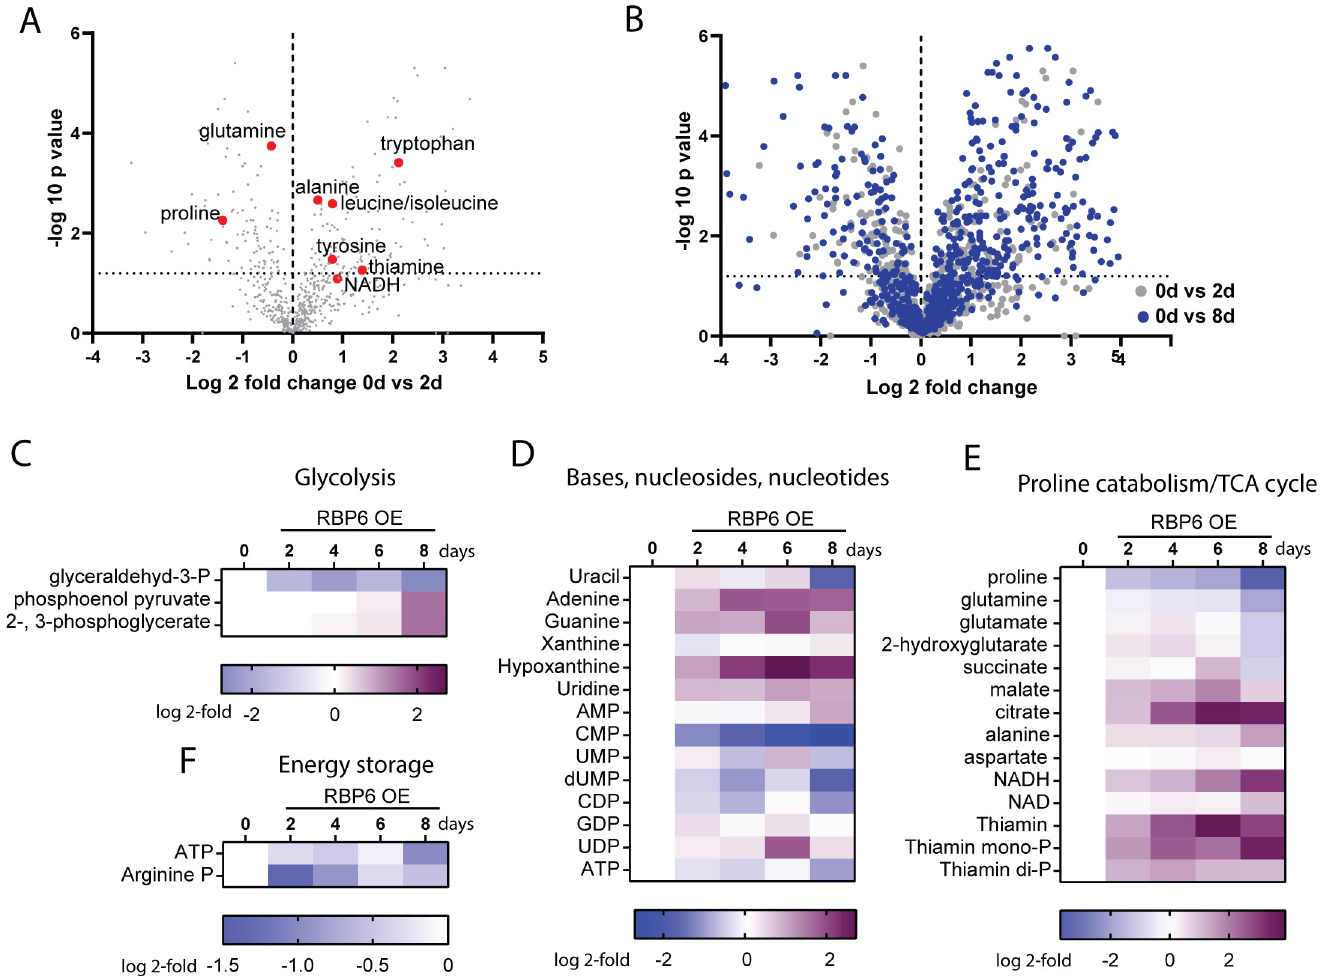
Fig 9. Metabolomics profiling of RBP6 OE cells. (A) Volcano plot showing the full metabolome (698 metabolites) analyzed at day 0 and day 2 upon RBP6 induction. Log2 fold change values of the average of mean peak area from quadruplicate experiments are plotted against the respective − log10 transformed P values. Few key metabolites are highlighted. (B) Volcano plot showing the full metabolome analyzed at day 2 (gray) and 8 (blue) upon RBP6 induction compared to day 0. Log2 fold change values of the average of mean peak area from quadruplicate experiments are plotted against the respective − log10 transformed P values. (D, E, F) Heatmaps showing log2 fold change of average of mean peak area of selected metabolites identified in induced samples compared to uninduced (day 0). The color key differs for each map and is always located below the heatmap. Heatmaps were generated with GraphPad prism 8.2.0. RBP6, RNA binding protein 6; TCA, tricarboxylic acid.